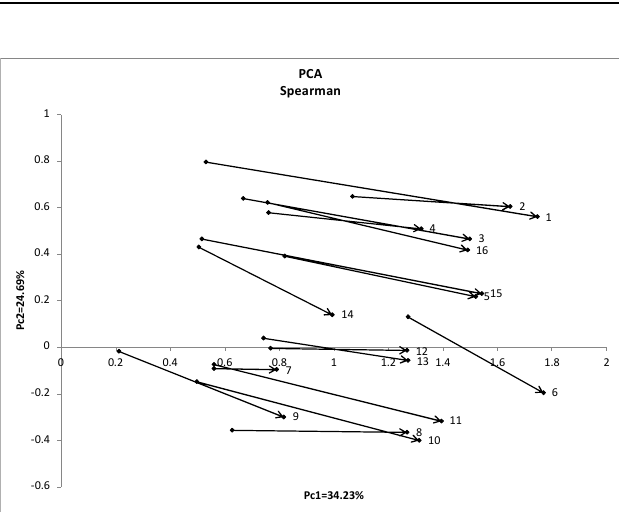
Figure 6 shows the result using the quantile method of PCA (Ichino [13]). Each num- bered arrow line connects the minimum and the maximum quantile vectors and describes the corresponding rectangular object. The oval structure embedded in the first two fea- tures cannot be reproduced in the factor plane. Any well-known correlation criterion fails to capture the embedded oval structure.